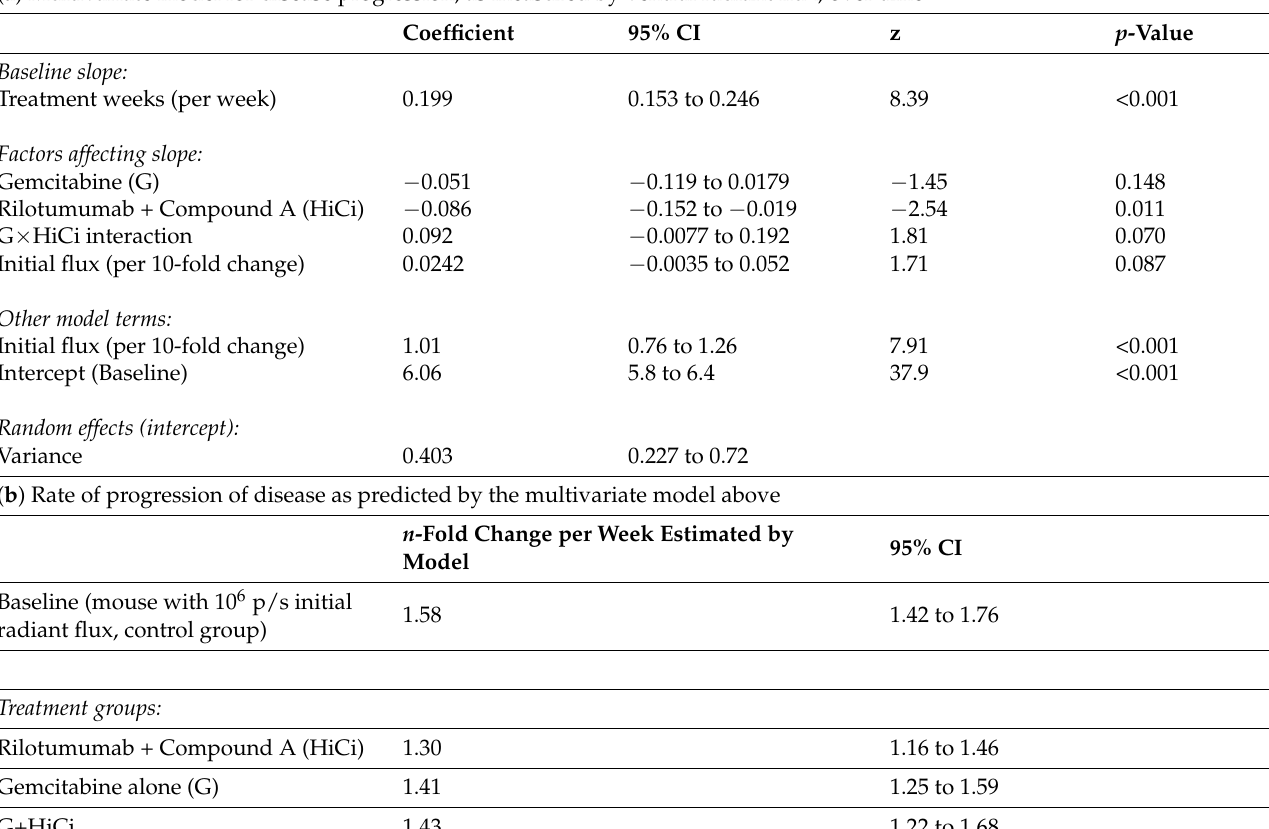
Table A3. Model specification for Figure 1c: Logistic regression model predicting probability of progressive disease. Progressive disease was defined by a statistically and clinically significant increase in the disease burden (see detailed definition in the text). The odds ratio represents the change in the odds of progressive disease when the relevant variable is true (compared to the baseline case). The intercept for this model represents the baseline odds of progressive disease. Odds Ratio 95% CI z p -Value Gemcitabine alone (G) 0.80 0.172 to 3.68 − 0.29 0.771 Rilotumumab + Compound A (HiCi) 0.15 0.0250 to 0.86 − 2.13 0.033 Initial flux (per 10-fold change from 10 6 p/s) 1.95 to 11.2 Baseline odds (Ctrl, initial flux of 10 6 p/s) Table A4. Model specification for Figure 1d: mixed-effects model for longitudinal analysis of tumour burden for mice with recurrent disease. ( a ) The Table shows the statistical model of the effect of treat-ments and initial tumour burden on the rate of progression of disease in this subgroup. The co-efficient for treatment weeks represents the baseline slope, while the coefficients for the interac-tion terms with treatment weeks (labelled in the table as “factors affecting slope”) represent fac-tors which change the slope of the disease burden curve. The units for these coefficients are log10 n-fold change of radiant flux per week. The baseline condition represents mice with an initial flux of 10 6 p/s in the control group, although the baseline for a given animal is assumed to vary (random intercepts model). ( b ) To assist the reader in interpreting this model, this Table shows the rate of progression of disease, predicted by the model, of mice under various conditions. The rate of change is expressed as an n-fold change in the radiant flux per